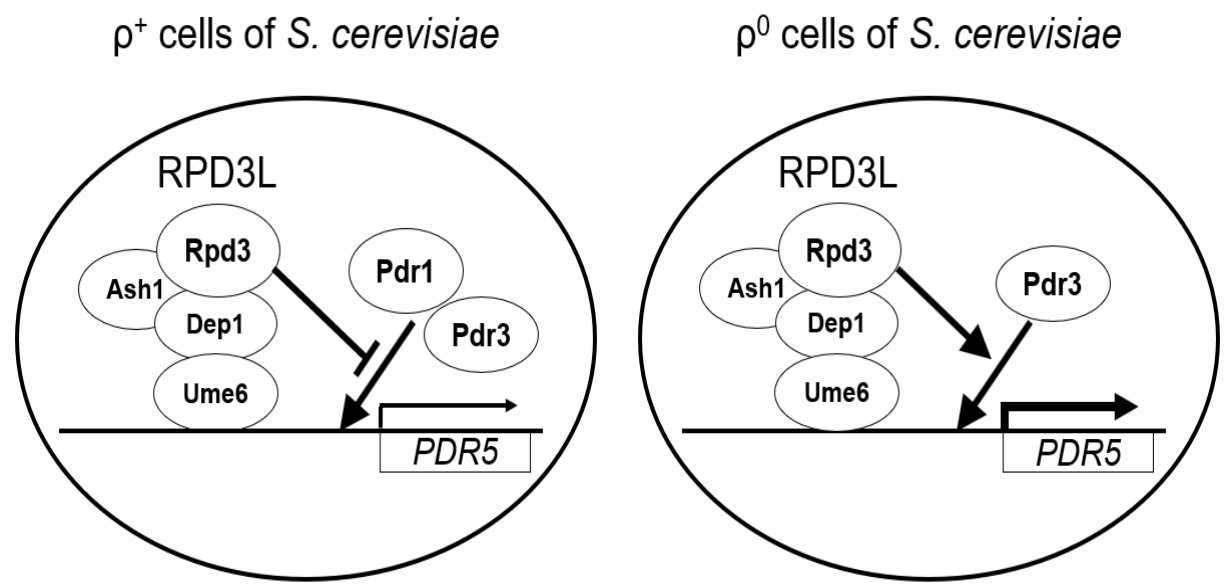
Figure 5. A simplified diagram of the regulation of basal transcription of PDR5 by Ume6 and Rpd3.